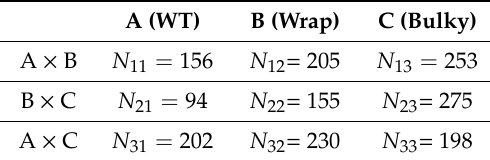
Table 5. Multinomial counts of progeny phenotypes from each of the three